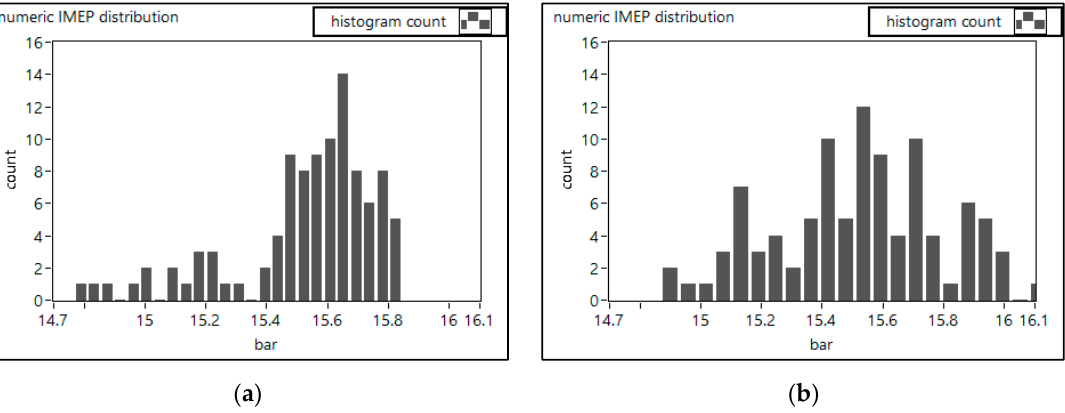
Figure 18. Histogram of numeric IMEP distribution; MAP = 1.6 bar, n = 2500 rpm, fuel NG. ( a ) Hill function, (mean value = 15.5 bar, SD = 0.236 bar); ( b ) Wiebe function, (mean value = 15.5 bar, SD = 0.292 bar).